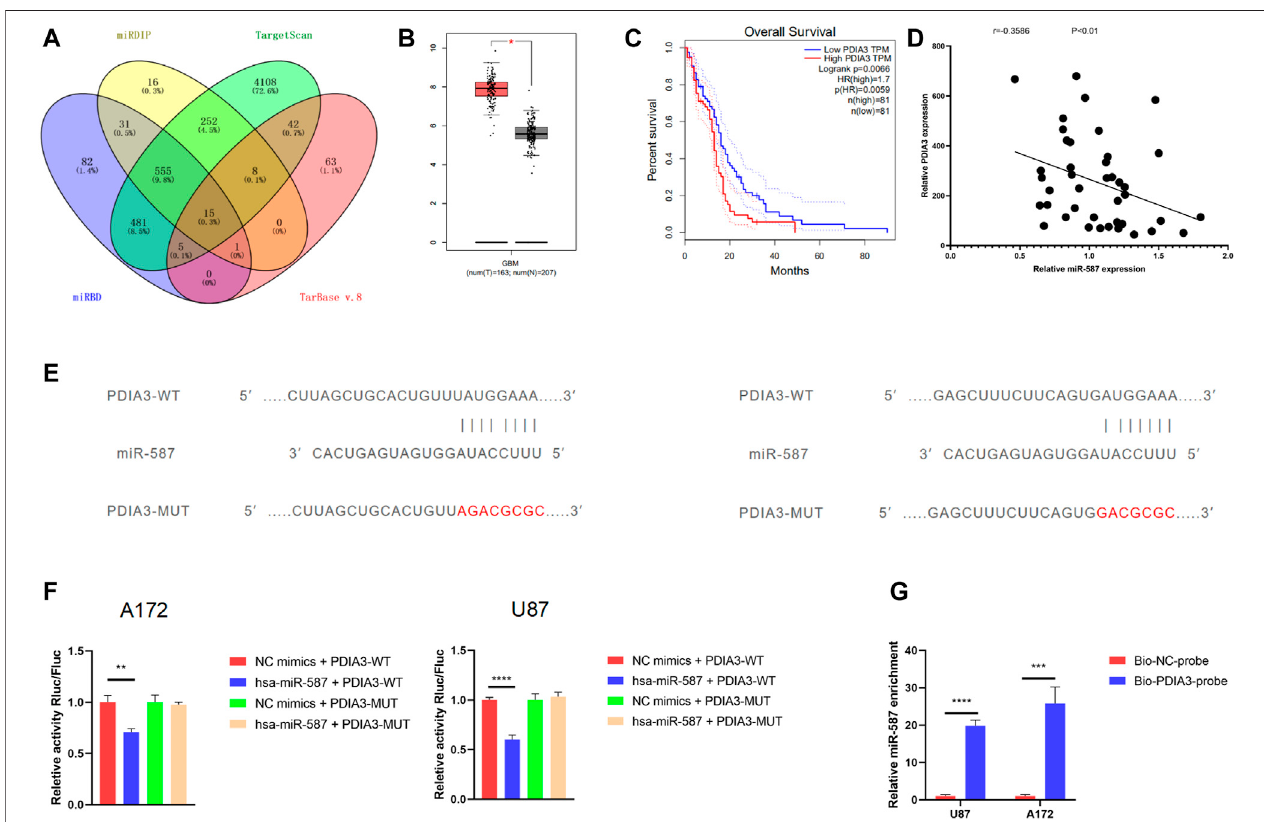
FIGURE 6 | PDIA3 was a downstream target of miR-587. (A) The Venn diagram shows 15 potential targets of miR-587 by overlapping the outcomes of the four algorithms. (B) The analysisofThe Cancer Genome Atlas glioblastoma (GBM) datasets showed thatPDIA3 had anobviouslyhigher expression level in 163GBM clinical tissues than in 207 normal brain tissues. (C) Kaplan – Meier survival analysis showed that PDIA3 expression was obviously correlated with worse overall survival. (D) The qRT-PCRresultsshowedthatPDIA3expressionwasnegativelycorrelatedwithmiR-587inGBMclinicalsamples. (E) Thewild-type(WT)andmutated-typebinding sites for miR-587 in PDIA3 mRNA. (F) The results of dual-luciferase reporter gene assaysshowed that the relative activity ofluciferase in U87 and A172cells transfected with the WT 3 ′ UTR sequence was obviously suppressed by miR-587 mimics. However, the relative luciferase activity did not change after the transfection of miR-587 mimics in U87 and A172 cells with the MUT 3 ′ UTR sequence. (G) After the RNA pull-down assay, qPCR showed that the 3 ′ UTR of PDIA3 mRNA was signi fi cantly enriched by miR-587. Statistical analysis was conducted with Student ’ s t -test. * p <